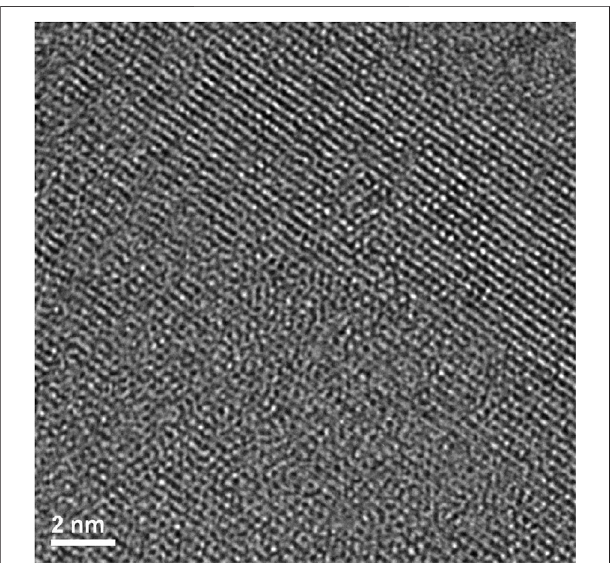
FIGURE 8 | High resolution TEM image of circled area of irradiated Er 2 Ti 2 O 7 from Figure 5 and the FFT of high-resolution image (inset).